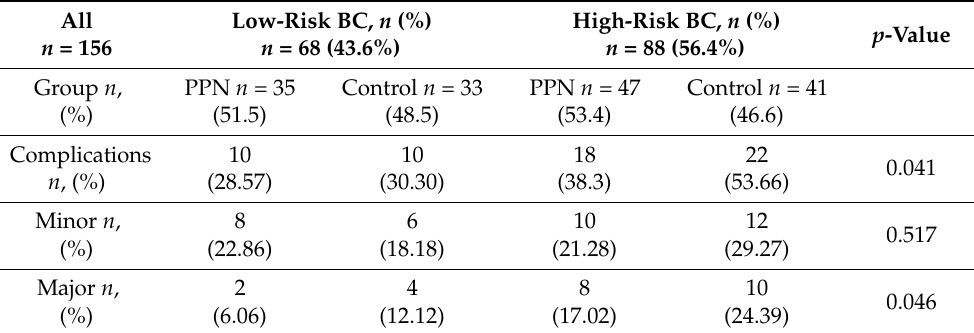
Table 3. Relationship of PPN and body composition with